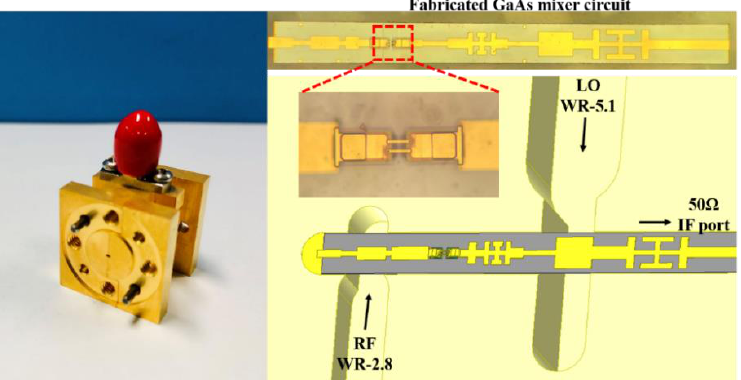
Figure 8. Photograph of the assembled SHM block with the K-connector for the IF output (left). Picture of the fabricated THz GaAs monolithic integrated SHM circuit and assembly diagram in the split block with the enlarged view of diode chip (right).